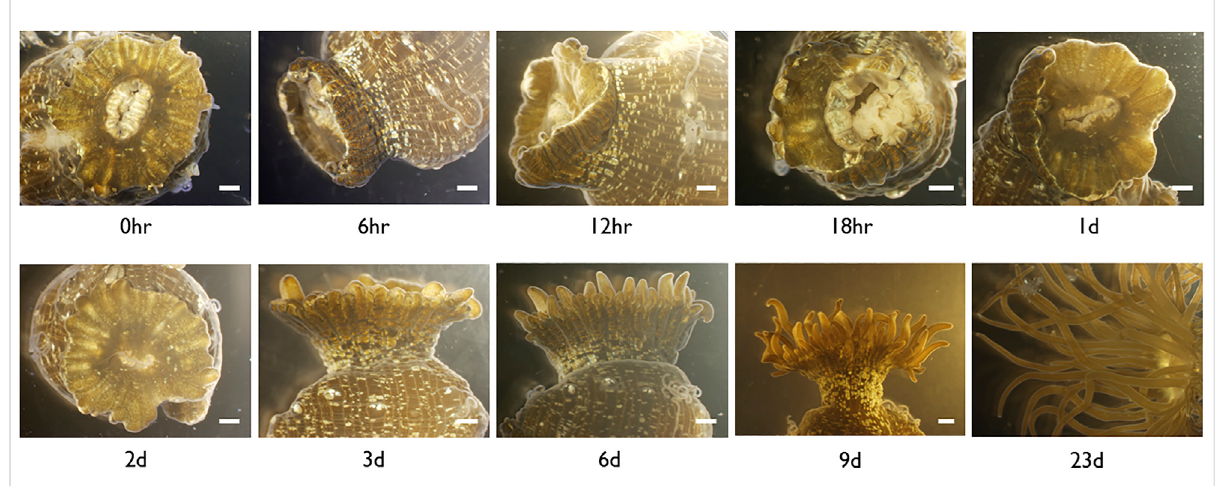
FIGURE 3 Microscopic images of Exaiptasia pallida cultured at 22 ° C with tentacles cut at the base from the moment of injury (0 h) to complete regeneration (Day 9). Scale bar, 1